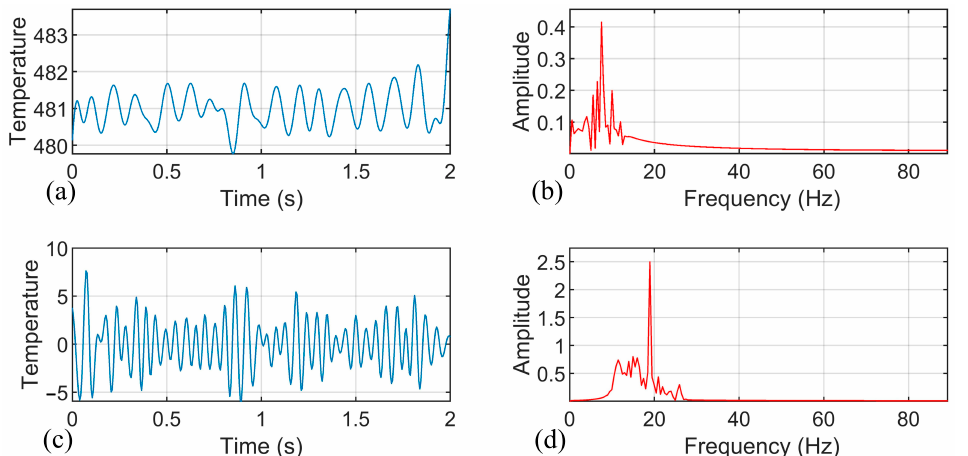
Figure 6. Temperature signal component of perfectly formed welds: ( a ) Temperature signal component decomposed by wavelet packet at node 7; ( b ) Spectrum of temperature signal component at node 7; ( c ) Temperature signal component decomposed by wavelet packet at node 8; and ( d ) Spectrum of temperature signal component at node 8.